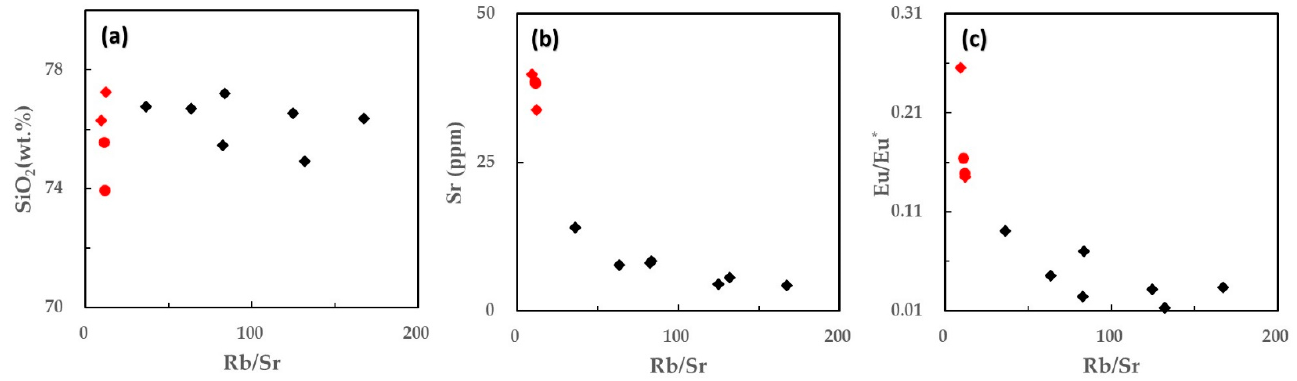
Figure 7. ( a ) SiO 2 , ( b ) Sr, and ( c ) Eu/Eu * vs. Rb/Sr variation diagrams; ● A group (ICP-MS data); ♦ A group (TIMS data); ♦ B group (TIMS data).